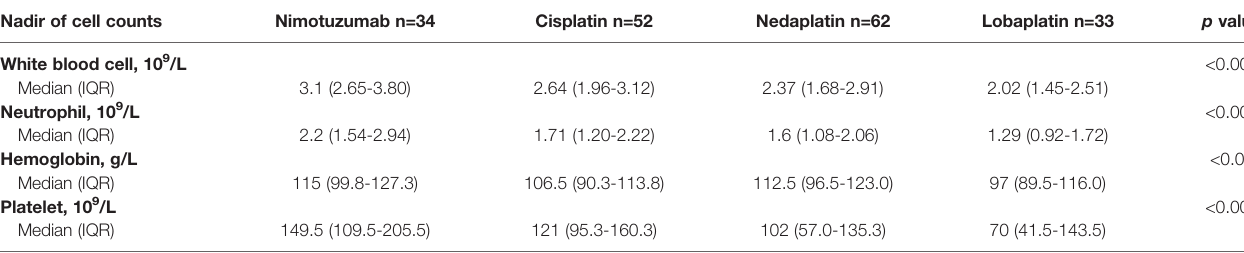
TABLE 3 | Nadir of blood cell counts during concurrent chemoradiotherapy in LAHNC patients.